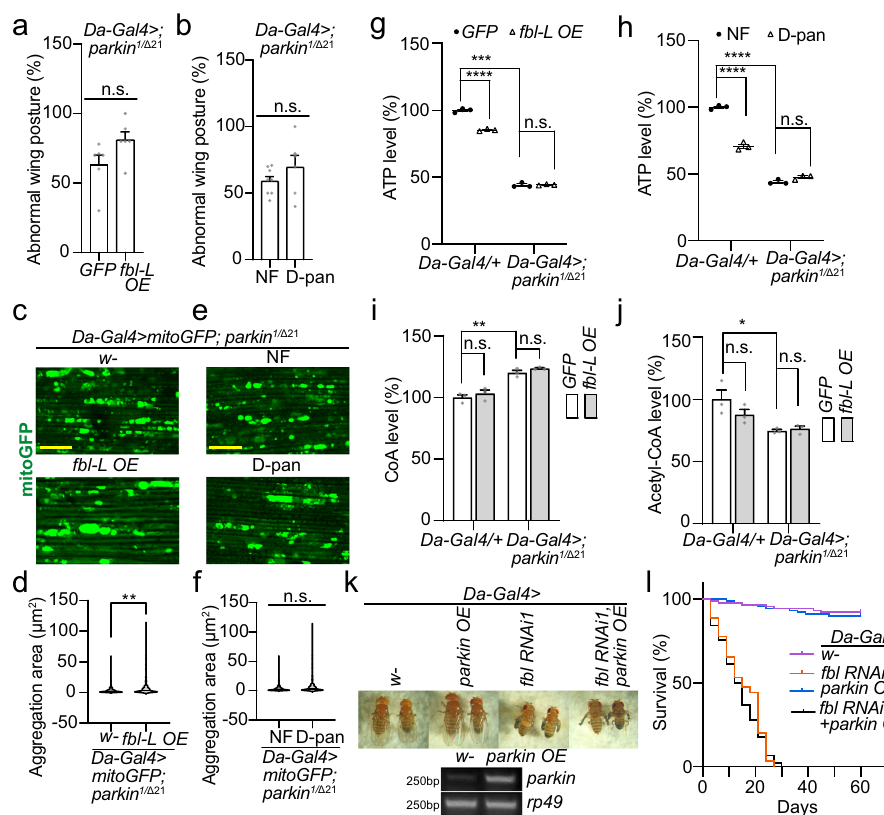
Fig. 4 fbl Does Not Genetically Interact with parkin . a , b No rescue effects of fbl-L OE ( a ) and D-pan alimentation ( b ) on wing posture defects in parkin mutant. 25 fl ies per genotype per group were tested; n = 6 biologically independent groups in assay ( a ); n = 8 (NF), n = 6 (D-pan) biologically independent groups in assay ( b ). c , e No rescue effects of fbl-L OE ( c ) and D-pan alimentation ( e ) on mitochondrial aggregation defects in parkin mutant muscles. Scale bars, 25 µ m. d , f Violin plots showing the quanti fi cations corresponding to ( c ) and ( e ). The signi fi cance was calculated by using two-proportion Z test, and the threshold was set at 3 µ m 2 ; n = 3 biologically independent samples in assays ( d ) and ( f ). g , h No effects of fbl-L OE ( g ) and D-pan alimentation ( h ) on ATP level reduction in parkin mutant. i , j No effects of fbl-L OE on CoA ( i ) and acetyl-CoA ( j ) levels in parkin mutant. n = 3 biologically independent samples in assay ( g – j ). For assays in ( a , g – j ), UAS-GFP serves as control. k No rescue effect of parkin OE on wing abnormal in fl ation caused by fbl RNAi, and RT-PCR showing the ef fi ciency of parkin OE. rp49 serves as loading control. l Effects of parkin OE on survival curve decline caused by fbl RNAi. 30 fl ies per group and 3 independent groups (90 fl ies in total) were tested per genotype. For assays in ( a , b , g – j ), the signi fi cance was calculated by using two tailed unpaired t-test. For assays in ( l ) the signi fi cance was calculated by Log-rank (Mantel – Cox) test. Data are presented as mean values± SEM; n.s. not statistically signi fi cant; * p < 0.05; ** p < 0.01; *** p < 0.001; **** p < 0.0001. Source data are provided as a Source Data fi CoA level (Supplementary Fig. 4d, e). In line with the elevated CoA level in the parkin mutant, similar to D-pan, 4 ’ -PPT could not rescue the abnormal wing posture and lifespan in parkin mutant (Supplementary Fig. 4f, g). Lastly, parkin OE did not ameliorate those defects caused by fbl RNAi in our assays, such as wing in fl ation and shortened lifespan (Fig. 4k, l). Taken together, Parkin and Fbl act somewhat independently downstream of PINK1 in regulating CoA metabolism and maintaining the normal mitochondrial homeostasis.